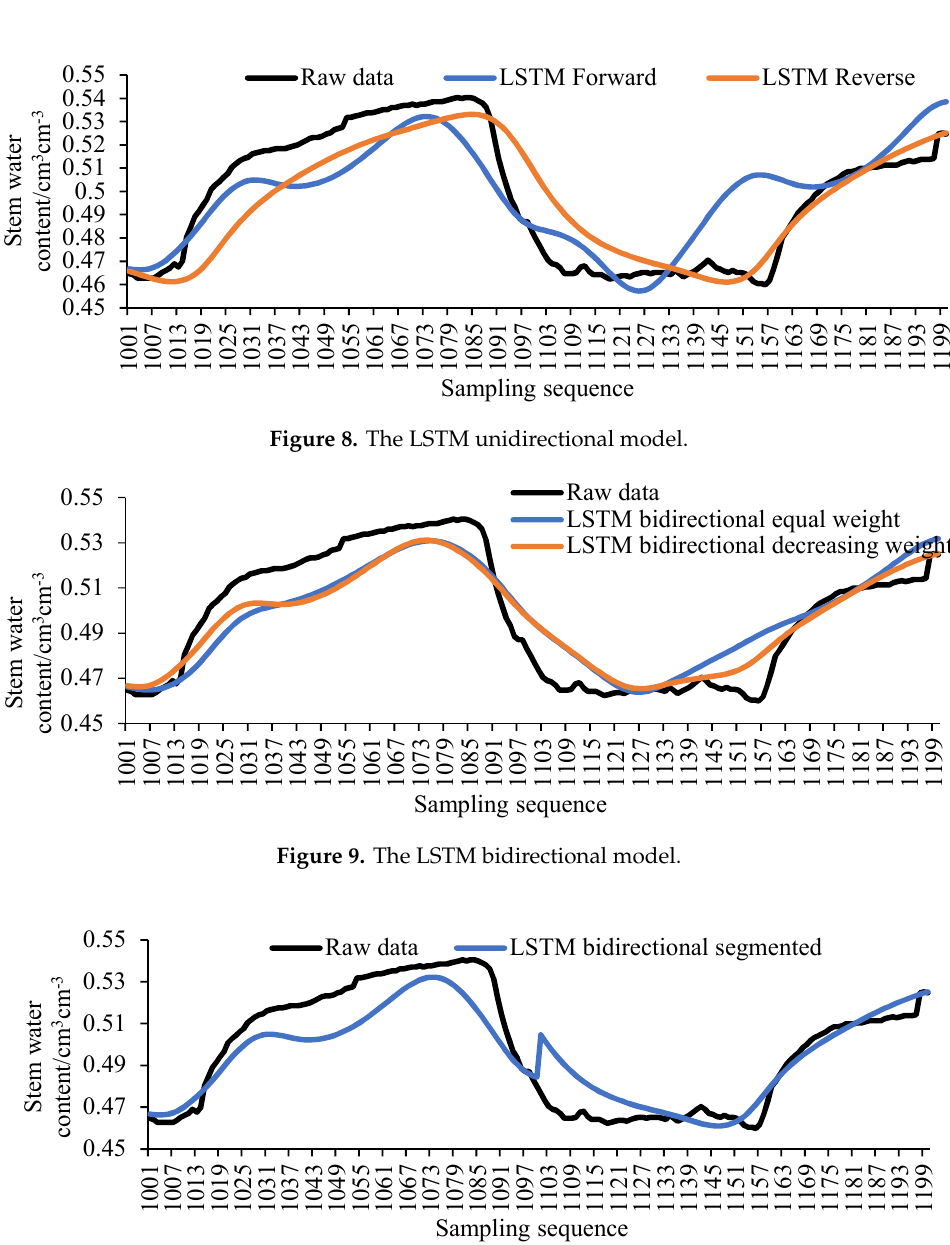
Figure 10. The LSTM bidirectional segmented model.